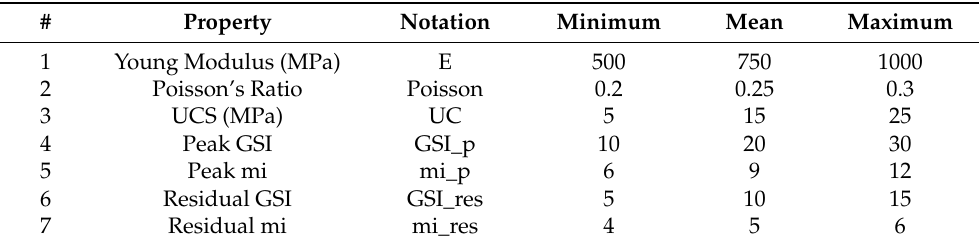
Table 1. Range of input parameters for the rock